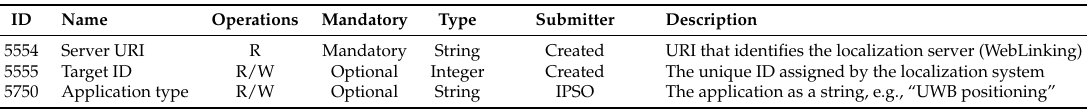
Table 4. Localization relay object based on LwM2M/IPSO (Object ID 3361).